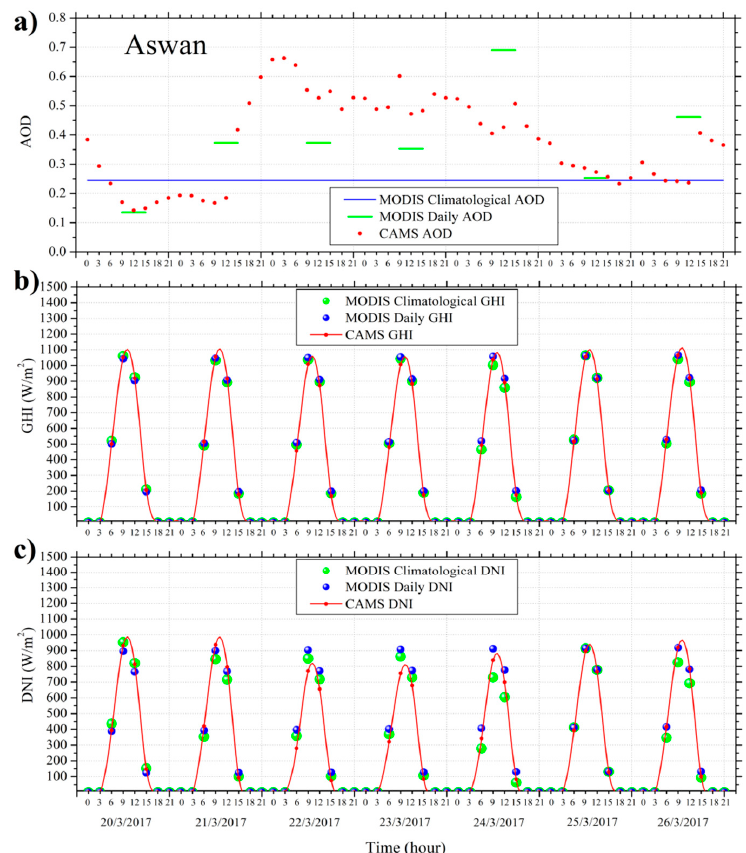
Figure 6. The AOD from MODIS climatology, MODIS daily observations and CAMS forecasts for a week period (20–26 March 2017) in Aswan ( a ) and the simulated by SENSE GHI ( b ) and DNI ( c )